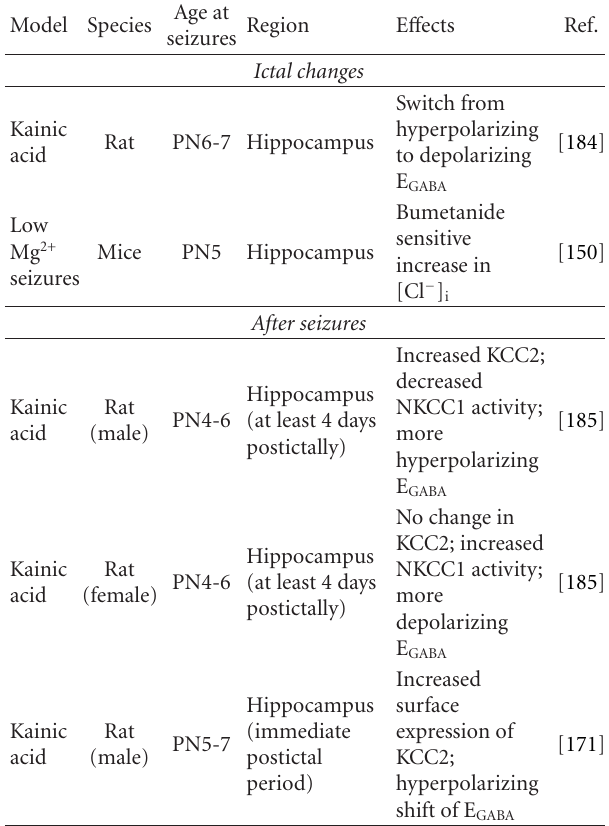
Table 4: E ff ects of Seizures on CCCs. Age at Model Species Region E ff ects seizures